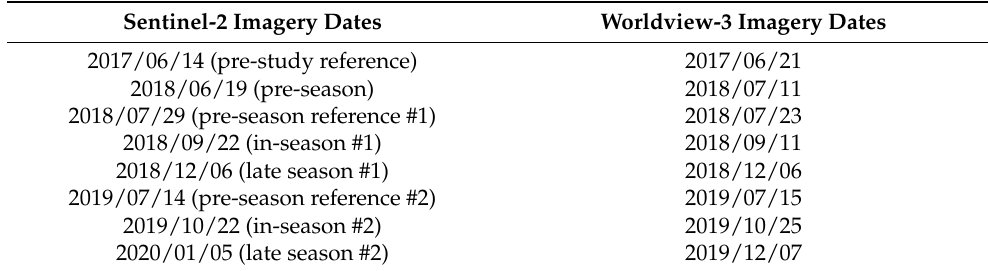
Table 1. Dates of acquisition of imagery used in the study for the development of the decline model and analysis of spectral trajectories.